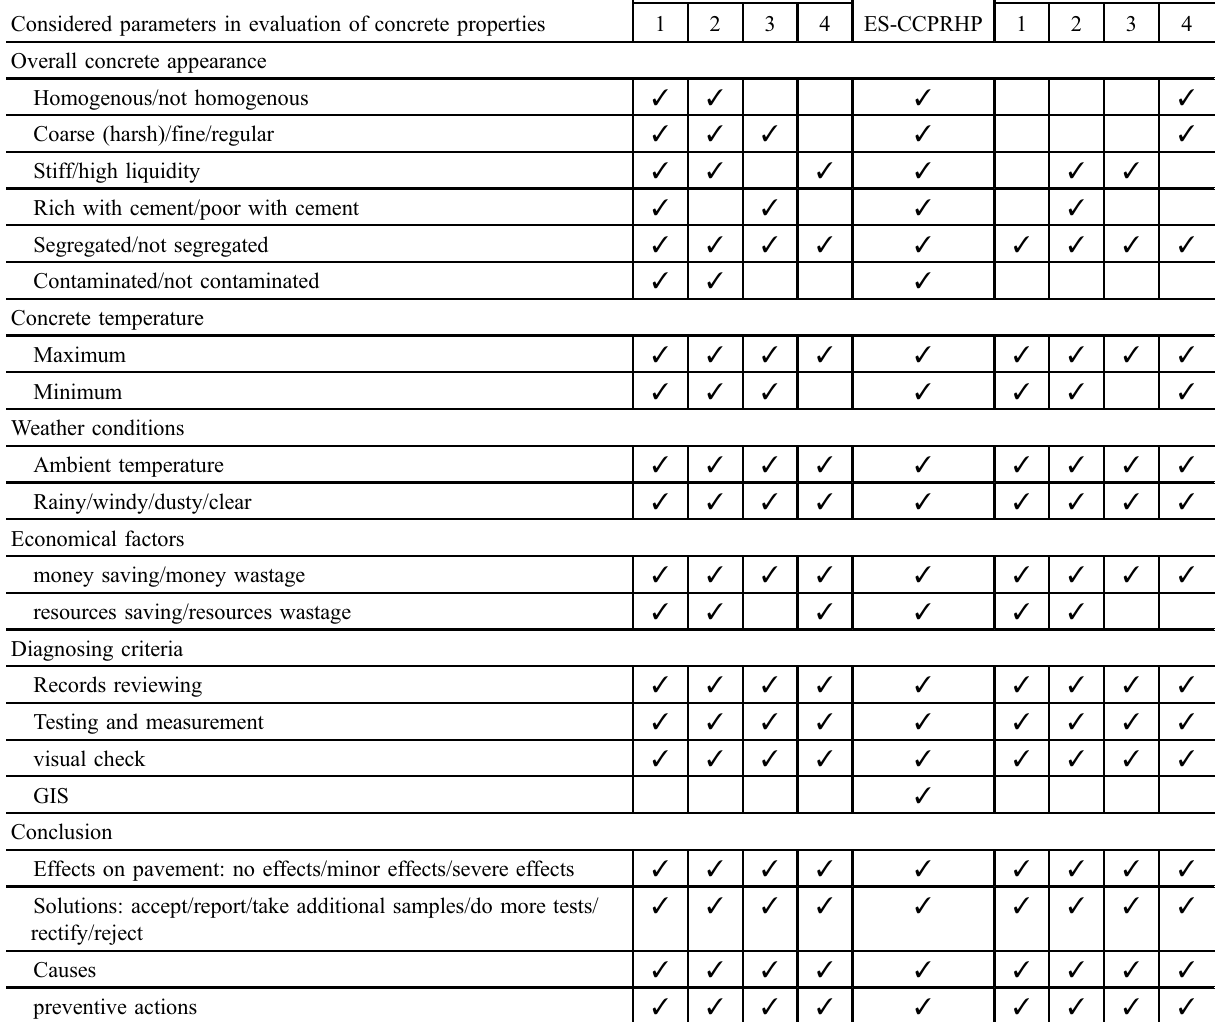
Table 7. Example of comparison between ES-CCPRHP and expert reasoning Considered parameters in evaluation of concrete properties